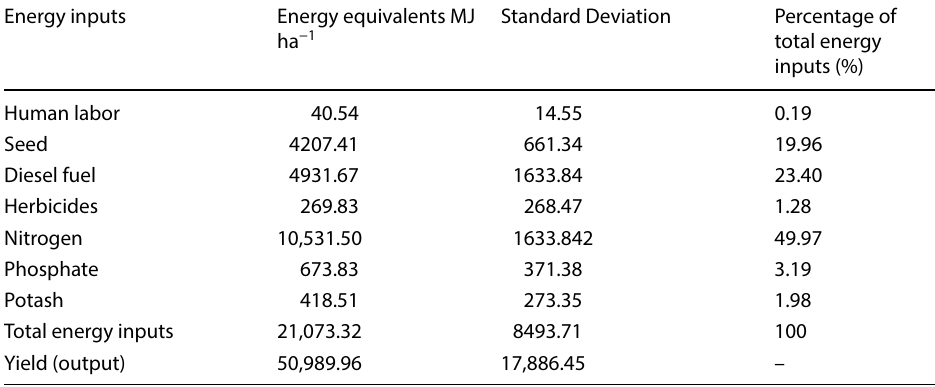
Table 3 Energy equivalents of input and